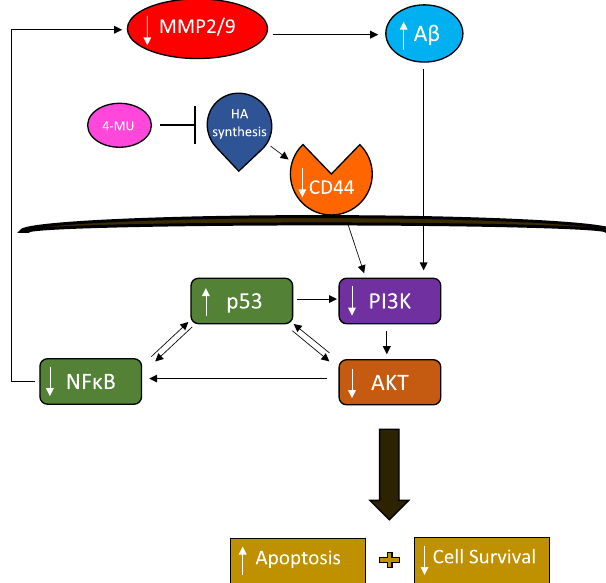
Figure 10. Representation of the main hypothesis and findings of this